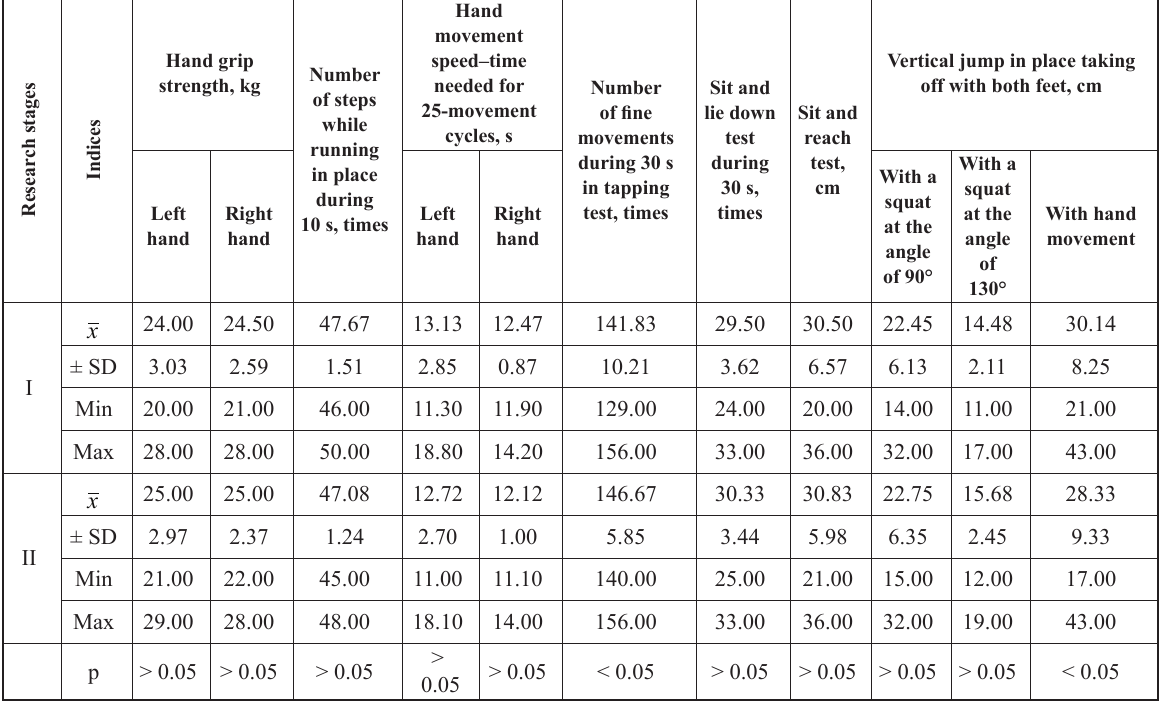
Sit and lie down test during 30 s, times